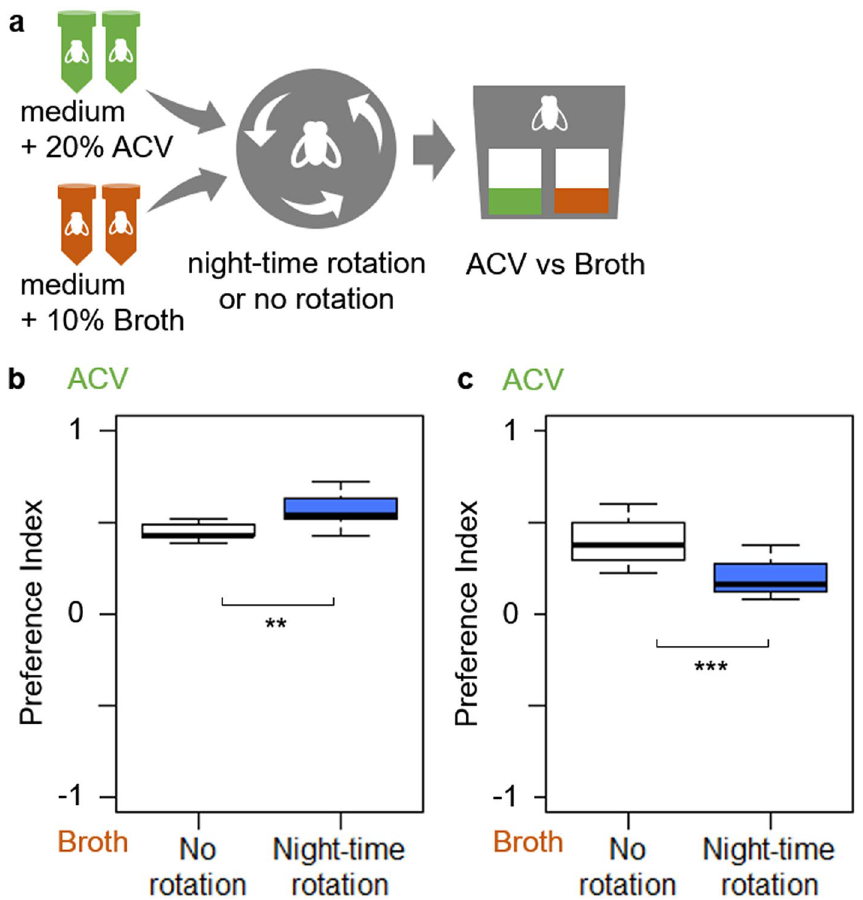
Figure 4. Olfactory preference of fruit flies under different sleep conditions for ACV and broth. ( a ) overview of the experiment using fruit flies reared on mediums supplemented by ACV or broth ( b ) Olfactory preferences of flies reared on ACV medium shown in a preference index (1 = absolute preference for ACV and − 1 = absolute preference for broth) (N = 10). ( c ) Olfactory preferences of flies reared on broth medium (N = 10). ** P < 0.01, *** P < 0.001